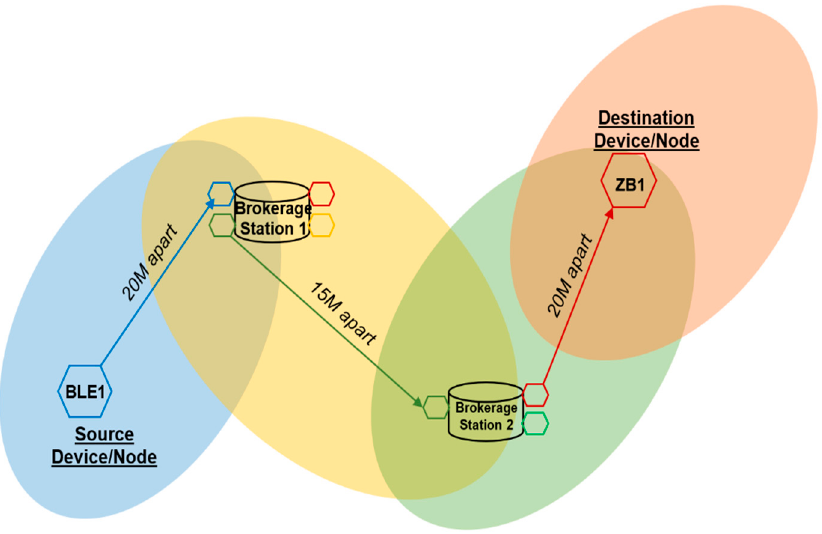
Figure 12. Communication between the BL1 node and ZB1 node.